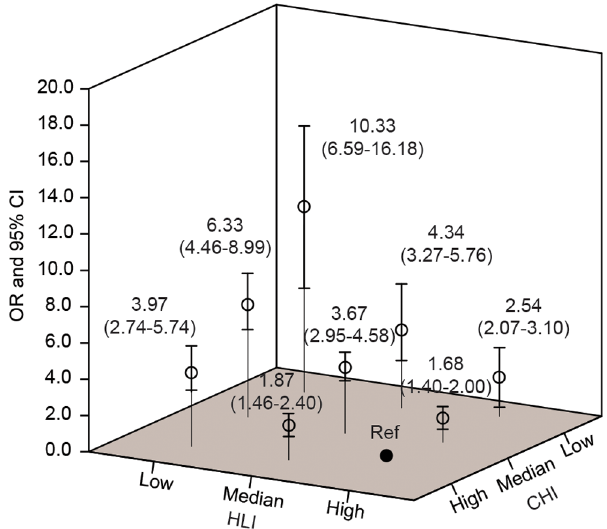
Fig 1. The joint effects of lifestyle factors and comorbidities history on colorectal cancer risk. Error bars indicate the 95%CI.